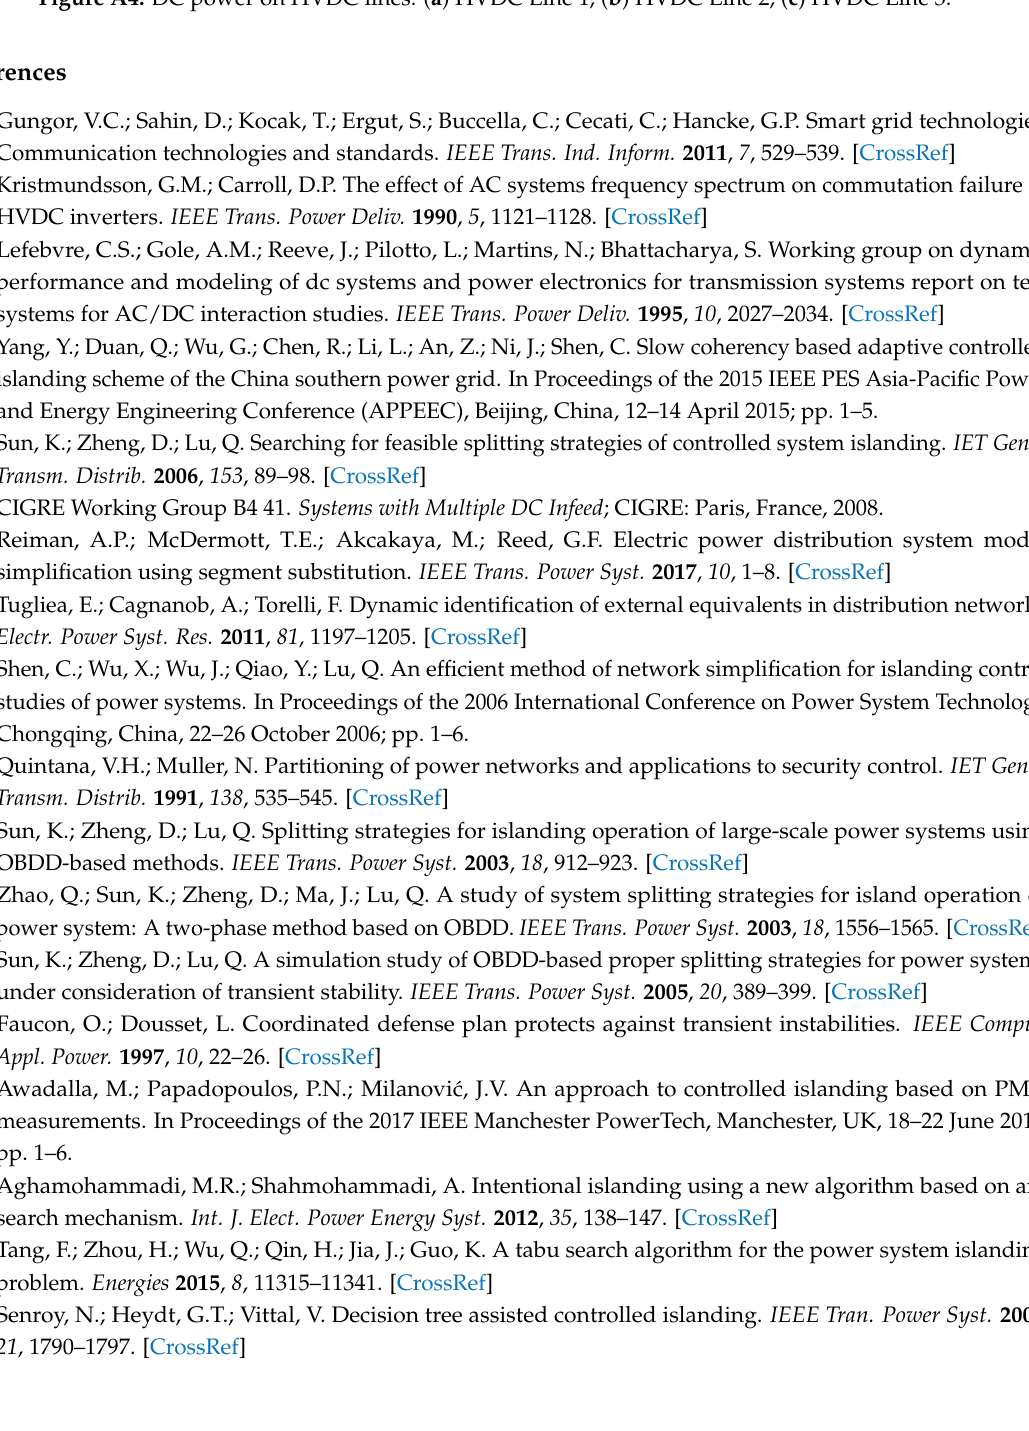
Figure A4. DC power on HVDC lines. ( a ) HVDC Line 1; ( b ) HVDC Line 2; ( c ) HVDC Line